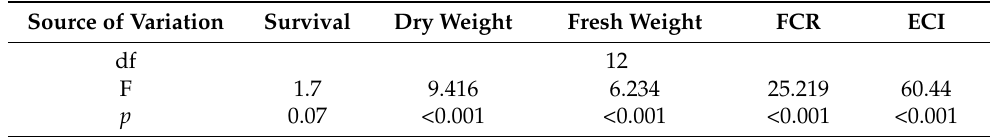
Table 2. Results of one-way ANOVA